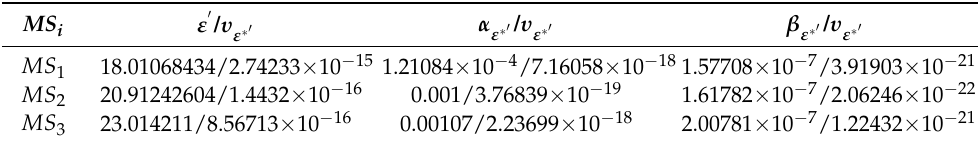
Table 6. The values of ε (cid:48) , α ε ∗(cid:48) and β ε ∗(cid:48) for MS sponges. MS i